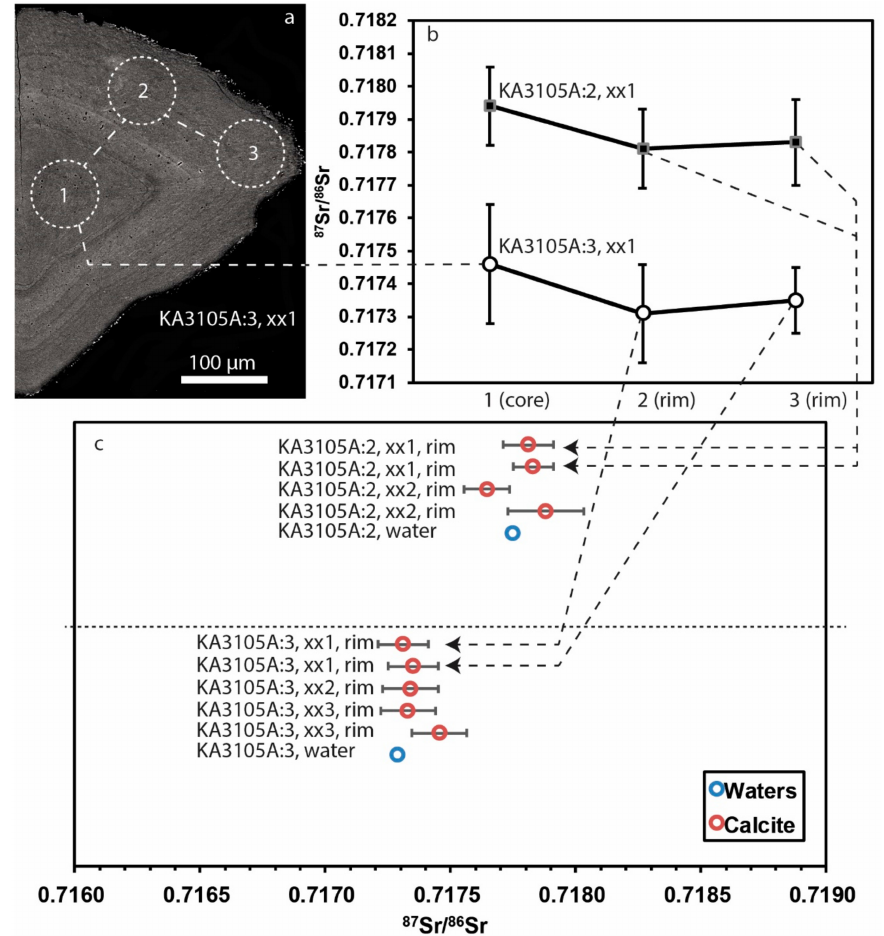
Figure 4. 87 Sr / 86 Sr values in modern calcite and water from Äspö borehole KA3105A, sections A:2 and A:3. ( a ) Back-scattered SEM-image of modern calcite precipitated in borehole section A:3, with growth zonation (growth direction from left to right). Positions for LA-MC-ICP-MS analyses in a transect are shown within the crystal and corresponding 87 Sr / 86 Sr values are shown in ( b ) together with values from a similar transect from A:2 calcite. ( c ) 87 Sr / 86 Sr values of outermost calcite overgrowths, compared to the 87 Sr / 86 Sr values of the water in the same borehole section. Error bars for the groundwater analyses are within the size of the